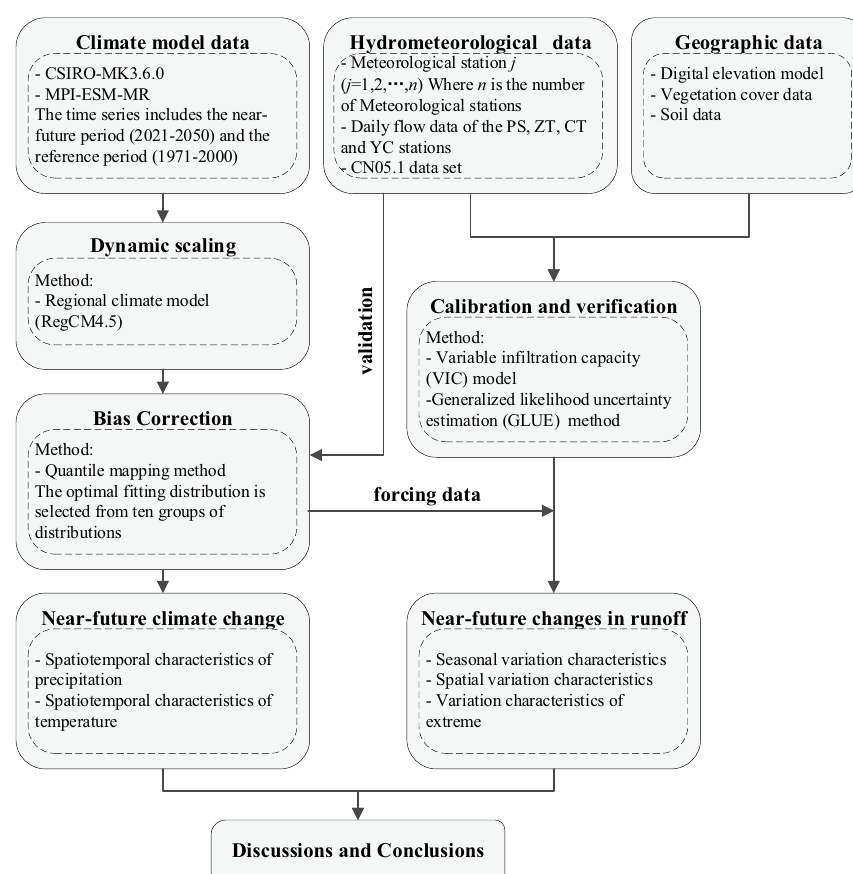
Figure 2. Modelling flowchart of this study. The figure was generated by Visio 2019 (https:// www. micro soft.